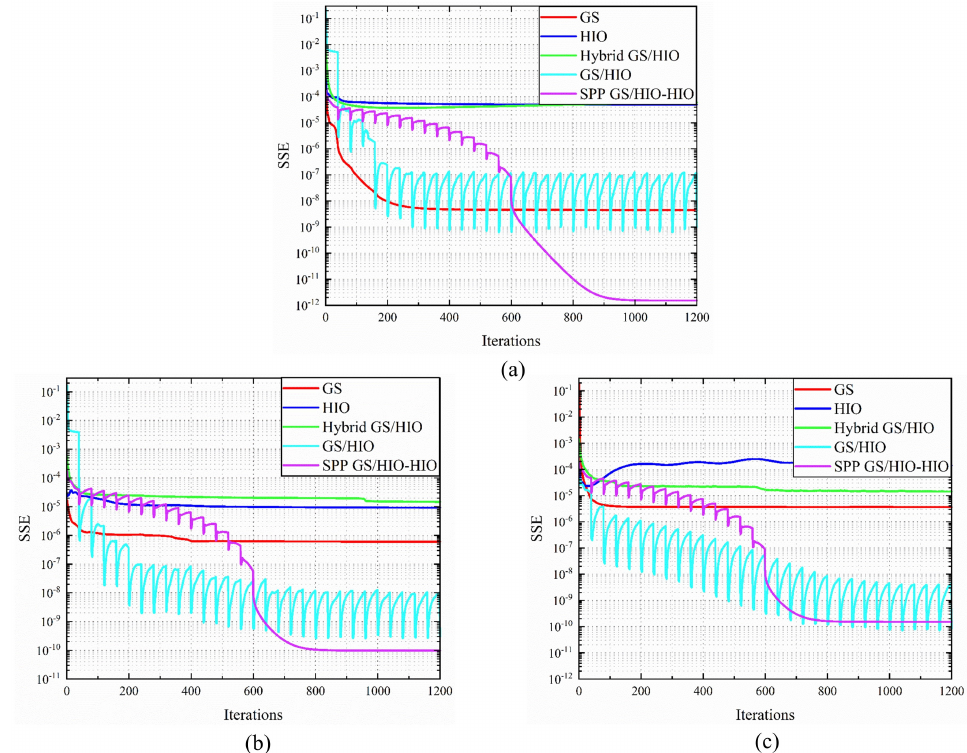
Figure 9. The comparisons of the cost function values of the proposed SPP GS/HIO-HIO algorithm and the other four algorithms at three different frequencies. ( a ) f = 75 GHz; ( b ) f = 138 GHz; ( c ) f = 220